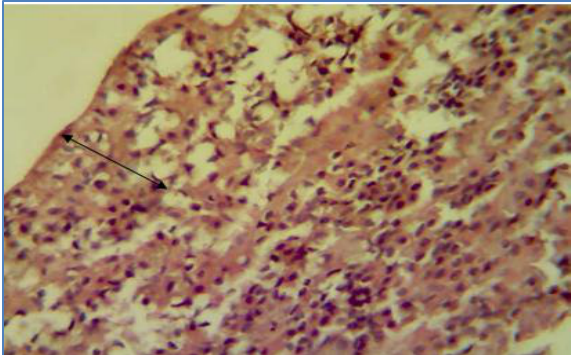
Figure, 1: Section in pituitary gland of animal treated with cadmium chloride (G1) shows marked apoptotic cells of pars distalis characterized by multiple spaces in their parenchyma ( ), (H and E stain 40X).